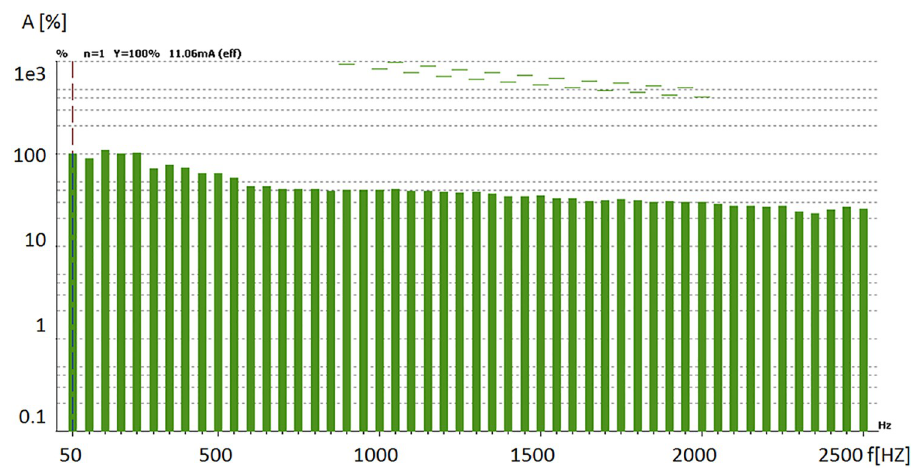
Fig 12. Higher order harmonics generated by the switching power